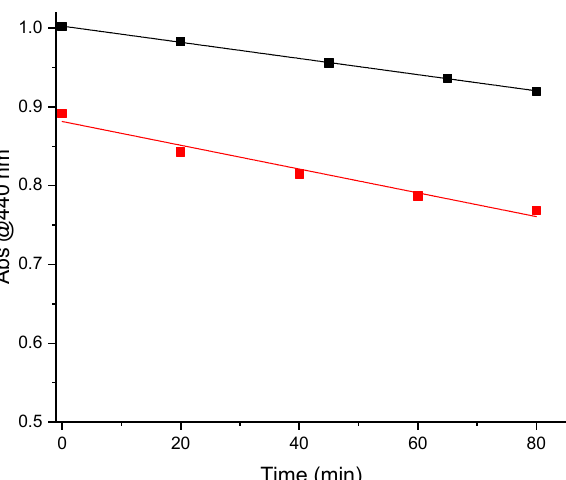
Figure 11. Absorbance variations ( λ = 440 nm) of AgNP@P(PEG350) 3 (black full square) and TPPS (red full square) aqueous solution in function of the irradiation time. The related lines represent the linear fit of the experimental data.